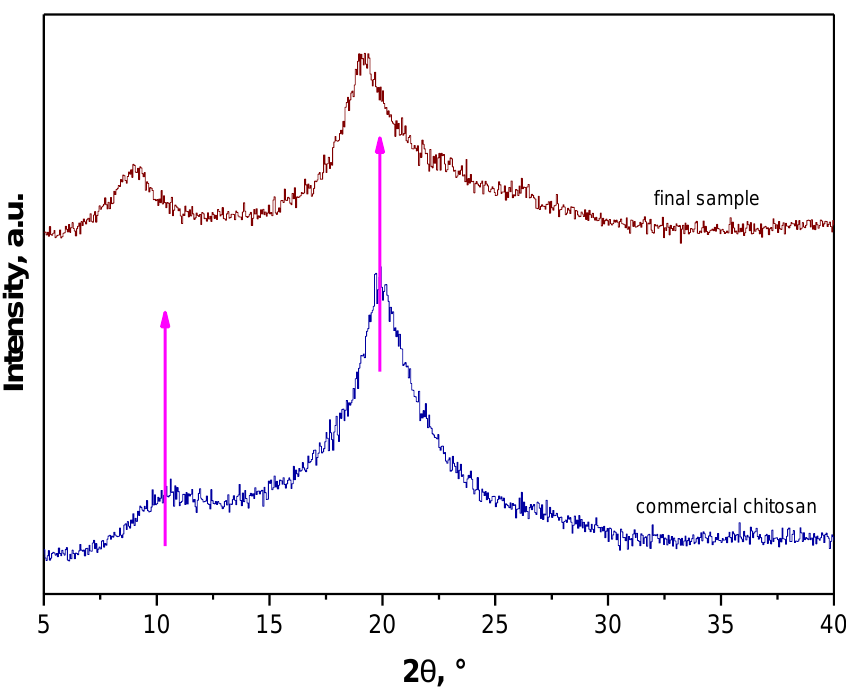
Figure 9. Results of XRD analysis of final sample (brown) and commercial chitosan (blue). Any significant differences between obtained XRD diffraction patterns of